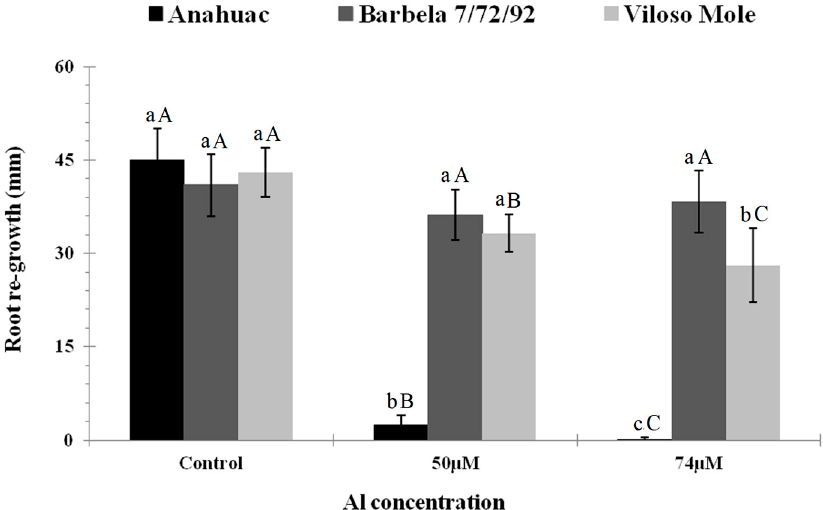
Figure 1. Root regrowth of three bread wheat genotypes (Barbela 7/72/92 and Viloso Mole, Al tolerant and Anahuac, Al sensitive) after exposure to different Al concentrations (0, 50 and 74 µ M Al). Bars denote ± SE ( n = 10). Means with different lowercase letters (a, b, c) represent significant differences among the genotypes in a particular Al treatment, whereas means with different capital letters (A, B, C) represent significant differences among the Al treatments with regard to a particular genotype at the p ≤ 0.05, according to Tukey’s test.